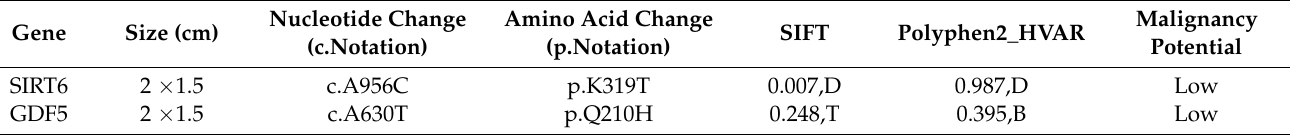
Table 3. Probable driver mutations of rare genes in wild-type